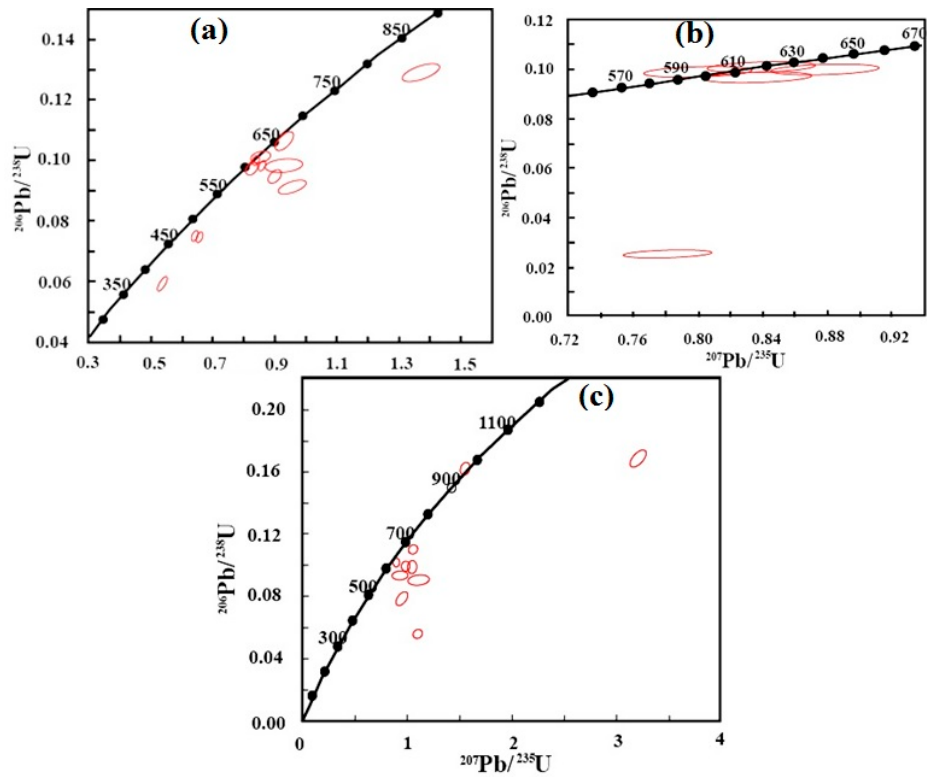
Figure 8. U-Pb zircon concordia plot and age determination for Nkogho I-type anatectic granite (modified from [5]).